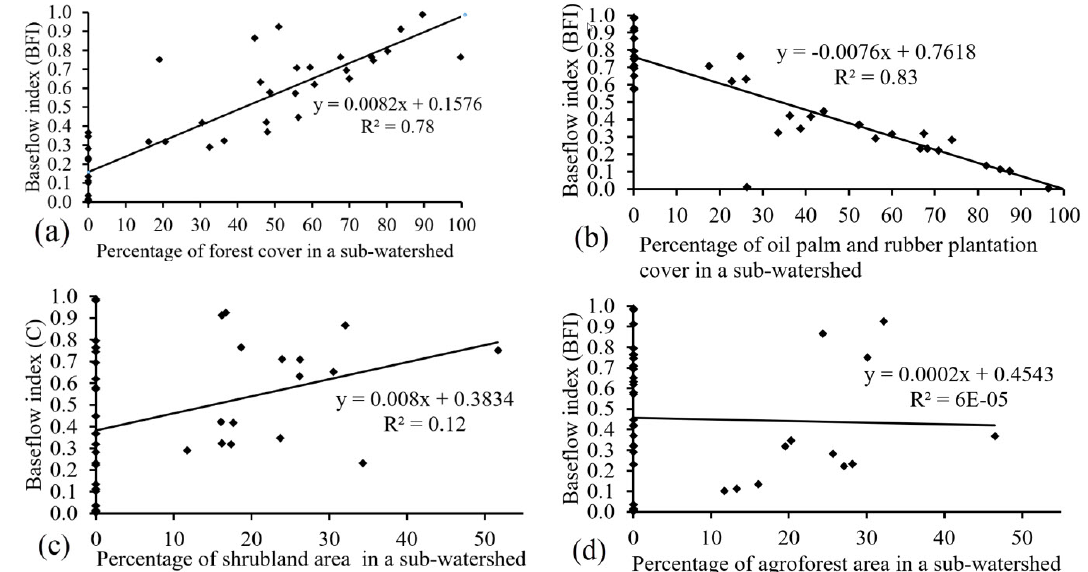
Figure 6. Association between simulated BFI values and the percentage of each land use type in a given